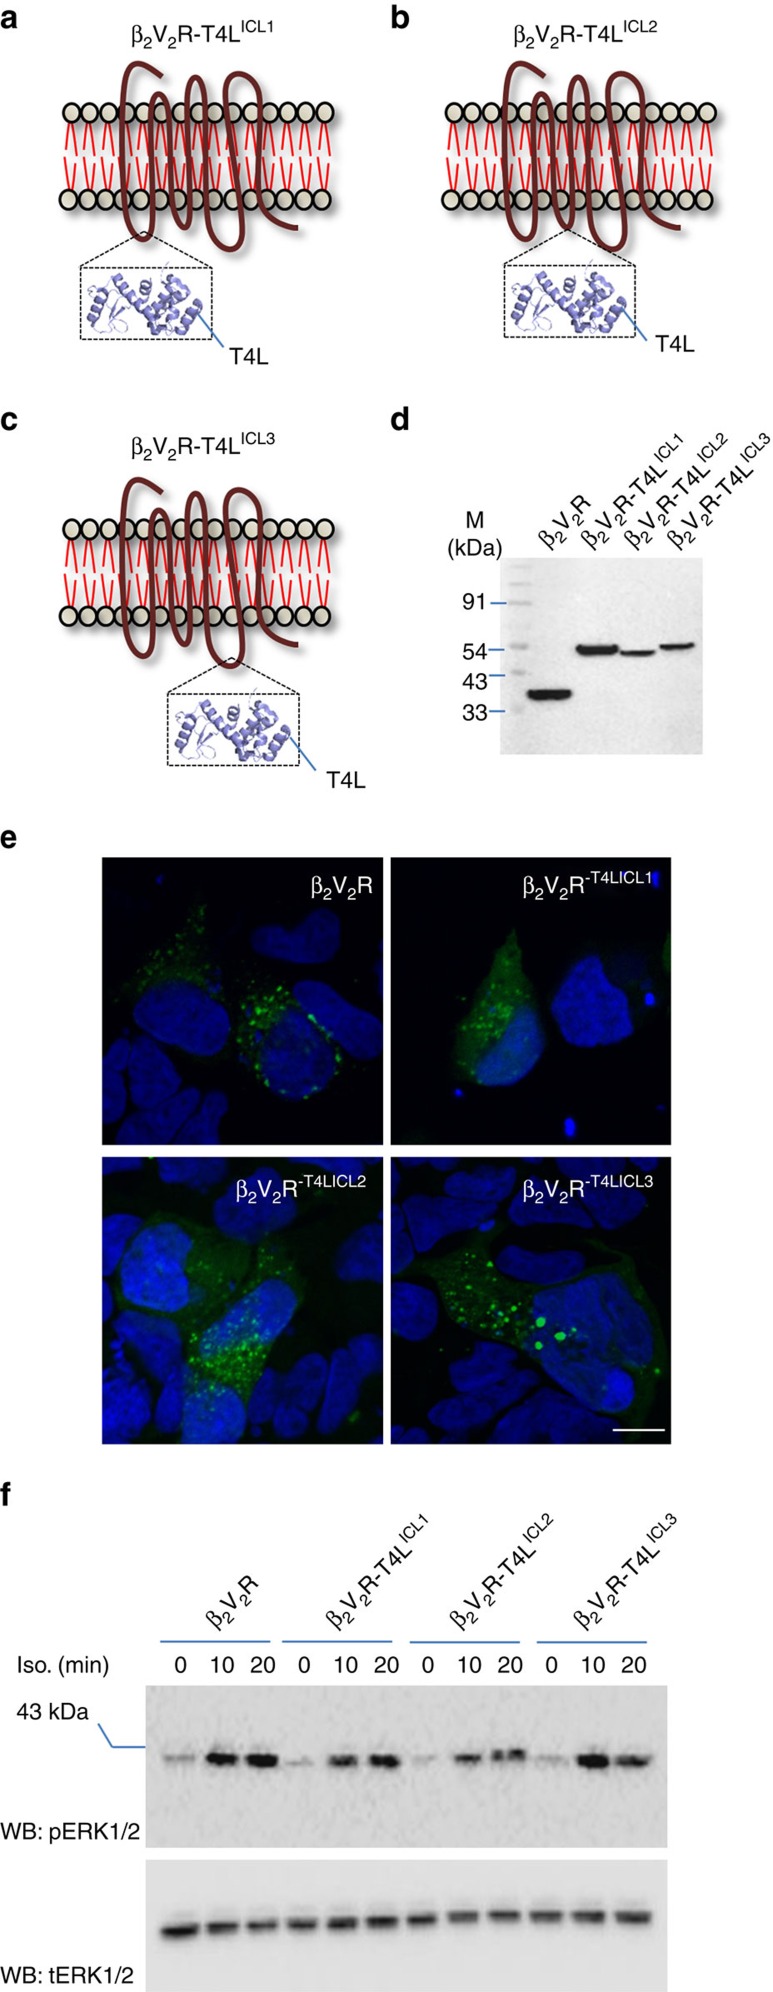
Blocking the potential contribution of intracellular loops does not affect ERK activation.Schematic illustration of β2V2R constructs with T4 lysozyme insertion in (a) intracellular loop 1 between Gln65 and Thr66 (b) intracellular loop 2 between Lys141 and Tyr142and (c) intracellular loop 3 between Glu238 and Glu268 with deletion of 239-267. (d) Expression of β2V2R-T4L constructs in transfected HEK-293 cells as visualized by western blotting using N-terminal FLAG tag. (e) Agonist induced βarr1 recruitment to β2V2R-T4L constructs as visualized by confocal microscopy in HEK-293 cells expressing βarr1-YFP. Scale bar, 10 μm. (f) Agonist (Isoproterenol, 10 μM) induced ERK1/2 activation in HEK-293 cells expressing β2V2R-T4L constructs at indicated time points. Data in f show a representative image of three independent experiments.